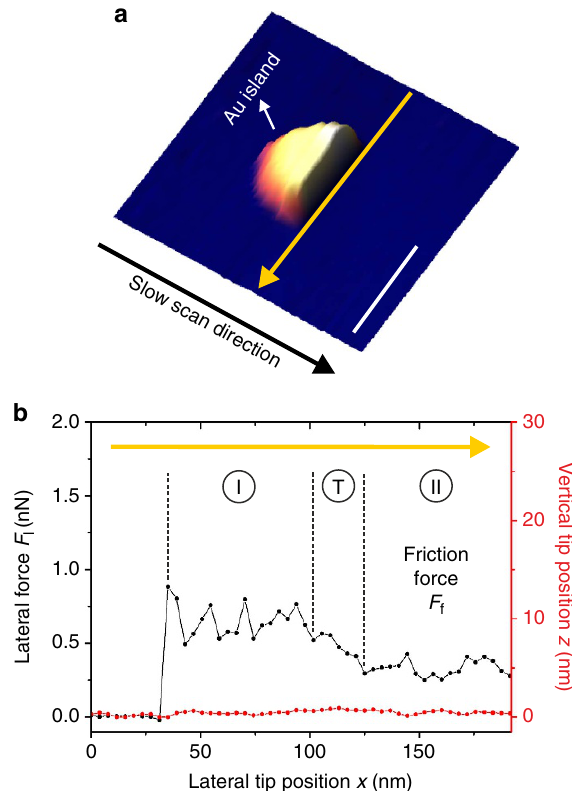
Figure 2 | Lateral manipulation of gold islands on graphite. ( a ) Three- dimensional representation of an AFM image detailing the lateral manipulation of a single gold island on graphite. The island is manipulated by the AFM tip along the yellow arrow, and thus appears ‘cut’ afterwards. Scale bar, 100nm. ( b ) The lateral force F l (black) and vertical tip position z (red) signals recorded during manipulation along the yellow arrow. Note that the z signal remains constant during manipulation, thus confirming that the tip pushes the island from the side. While recorded F l values consistently and remarkably remain below 1nN, two regions of relatively high and low friction (denoted by ‘I’ and ‘II’) can be discerned, separated by a short transition regime (denoted by ‘T’). The interfacial friction value F f and associated error bars are extracted from region